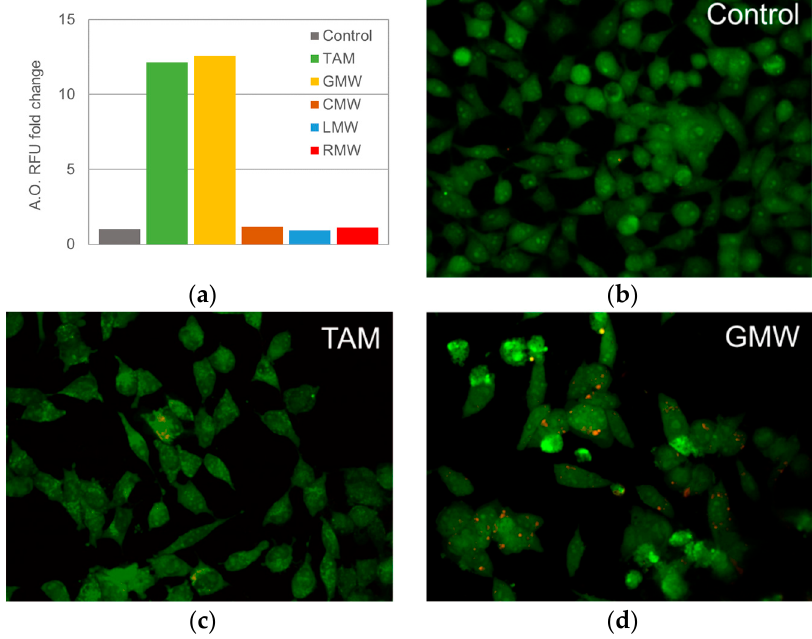
Figure 5. ( a ) Relative fluorescence units (RFU) compared to control. HeLa cells were treated for 24 h with 100 µg/mL of each extract. ( b – d ). Representative images of fluorescence microscopy after 24 h of incubation with 10 µM of TAM and 100 µg/mL of GMW. Captured images in green and red were merged using ImageJ.